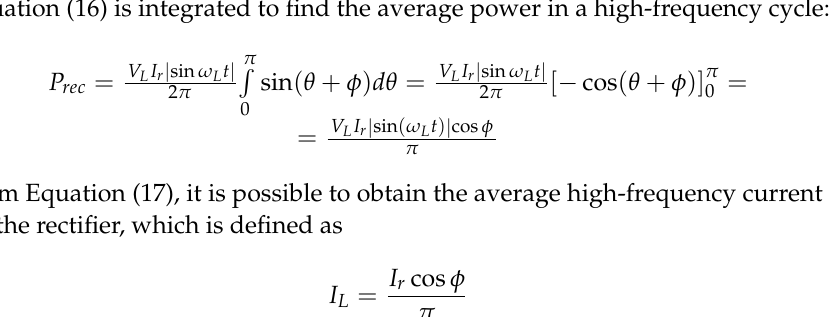
Figure 12. Instantaneous current delivered by the rectifier seen at a high frequency.